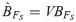
Steady-state solutions.Four stacked bars are plotted for each case: the first bar shows the number of free and bound susceptible bacteria, B^FS=VBFS and B^BS=ArBBS, at steady-state in the untreated scenario; the second bar shows the number of free and bound resistant bacteria, B^FR=VBFR and B^BR=ArBBR, at steady-state in the antibiotic only scenario; the third bar shows the number of free and bound susceptible bacteria at steady-state in the inhibitor only scenario, and the fourth bar shows the number of free and bound resistant bacteria at steady-state in the antibiotic and inhibitor scenario. There are no resistant bacteria at steady-state in the absence of antibiotic, nor are there any susceptible bacteria at steady-state in the presence of antibiotic. Thus, the combined height of the bars in each stack gives the total number of bacteria, BT. Treatment with antibiotics alone reduces the total bacterial burden in Cases A, C and D, and increases it in Case B. Treatment with inhibitors alone reduces the total bacterial burden in Cases A and B, increases it in Case C and has a negligible effect in Case D. Treatment with both antibiotics and inhibitors eliminates the bacterial burden in Cases B and C, and reduces it more than either treatment in isolation in Cases A and D. Steady-state solutions to Eqs 1–10 were calculated using Maple, neglecting the Heaviside step functions which prevent the logistic growth of bacteria when their population size goes beneath one. Parameter values: ψ˜Bac=0 hr−1, ψ˜I=0 hr−1, λ = 0 cm3cell−1hr−1, ρ = 0 hr−1, ω = 1, A = 0 or 8 μg cm−3, and IFinit=0 or 6.12×107 inhib. cm−3. See Tables 2–4 for the remaining parameter values.